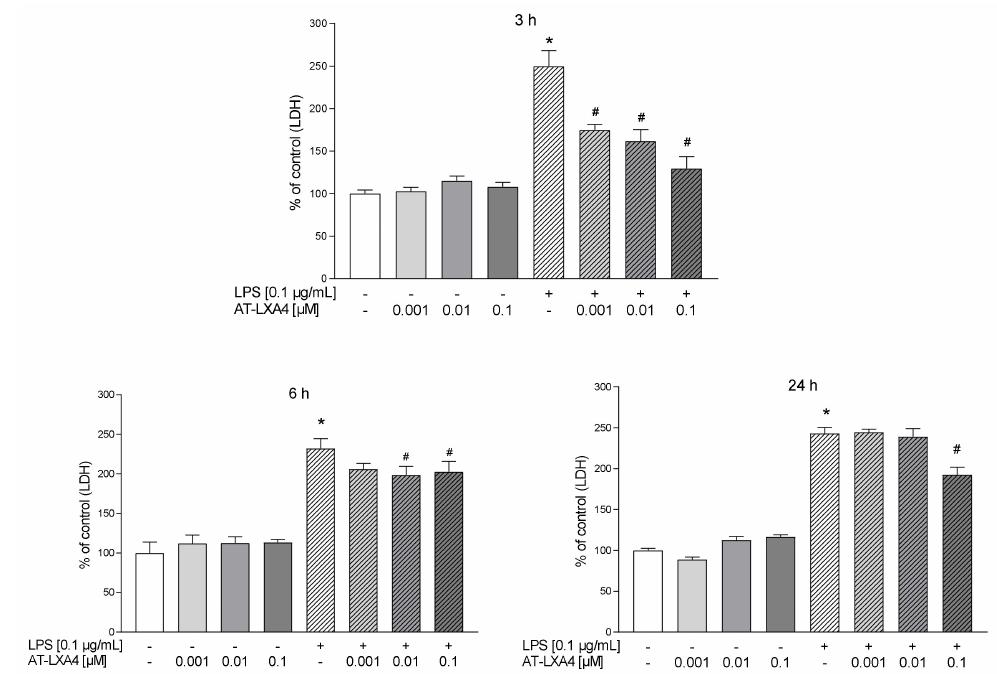
Figure 2. The impact of AT-LXA4 on LPS-induced LDH release in rat microglial cultures. The cells were preincubated with AT-LXA4 (0.001–0.1 µ M) for 1 h and then treated with 0.1 µ g/mL LPS for 3, 6, and 24 h. Control cultures were treated with the appropriate vehicle. The data are presented as the mean ± SEM percentage of control (vehicle-treated cells) of independent experiments, n = 2–5 in each experiment. * p < 0.05 vs. control group, # p < 0.05 vs. LPS group.